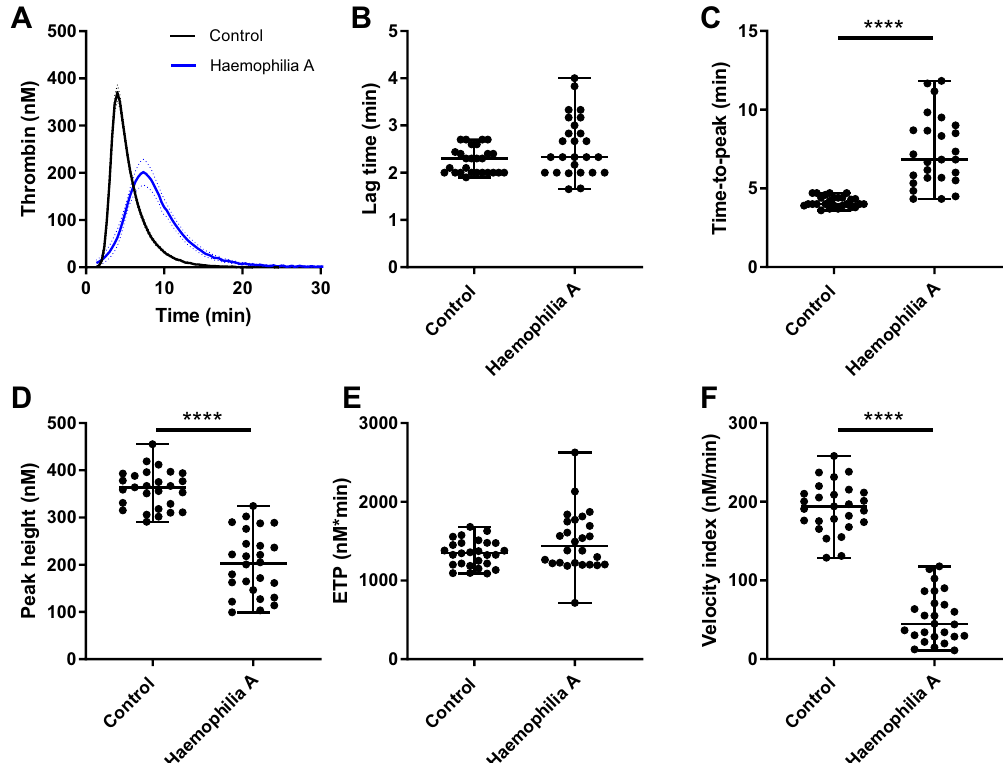
Figure 2. Thrombin generation in haemophilia A triggered with 5 pM tissue factor. TG was triggered with 5 pM TF and the average curves for the patient and control group are shown in ( A ). Individual TG curves were quantified by the lag time ( B ), time-to-peak ( C ), peak height ( D ), endogenous thrombin potential ( E ) and velocity index ( F ). TG curves are depicted as the mean curve (continuous line) ± the 95% confidence interval (dotted lines) and the parameter values are shown as the individual values with the median ± interquartile range. Statistical significance according to the Mann Whitney test is indicated as **** for a p -value <